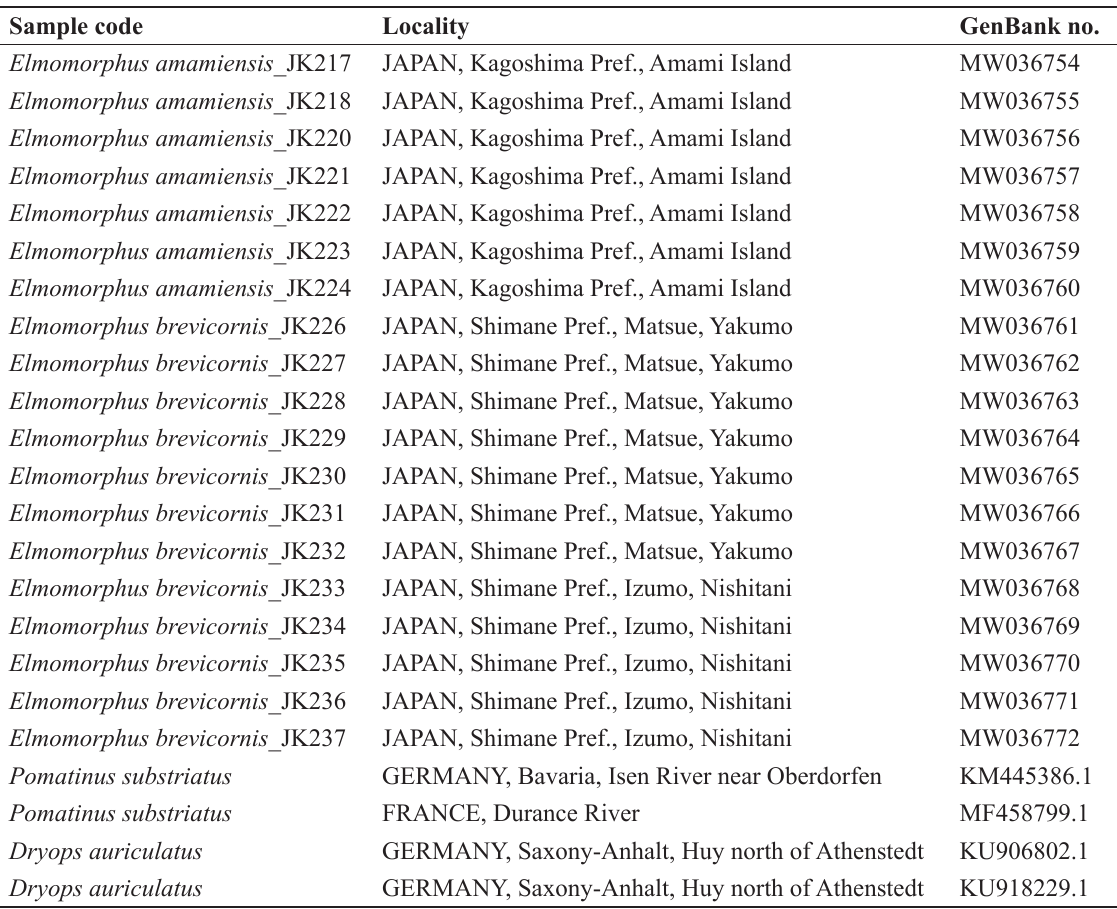
Table 1. Origin and GenBank accession numbers of COI sequences used in phylogenetic